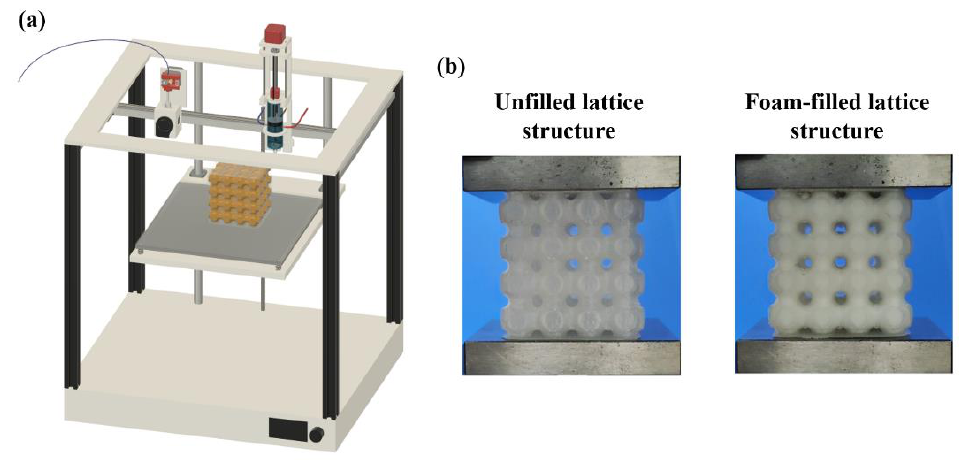
Figure 5. ( a ) CAD model of Hybrid FFF system, ( b ) 3D-printed unfilled and foam-filled lattice struc- tures. Table 2. Printing parameters for PETG filament.